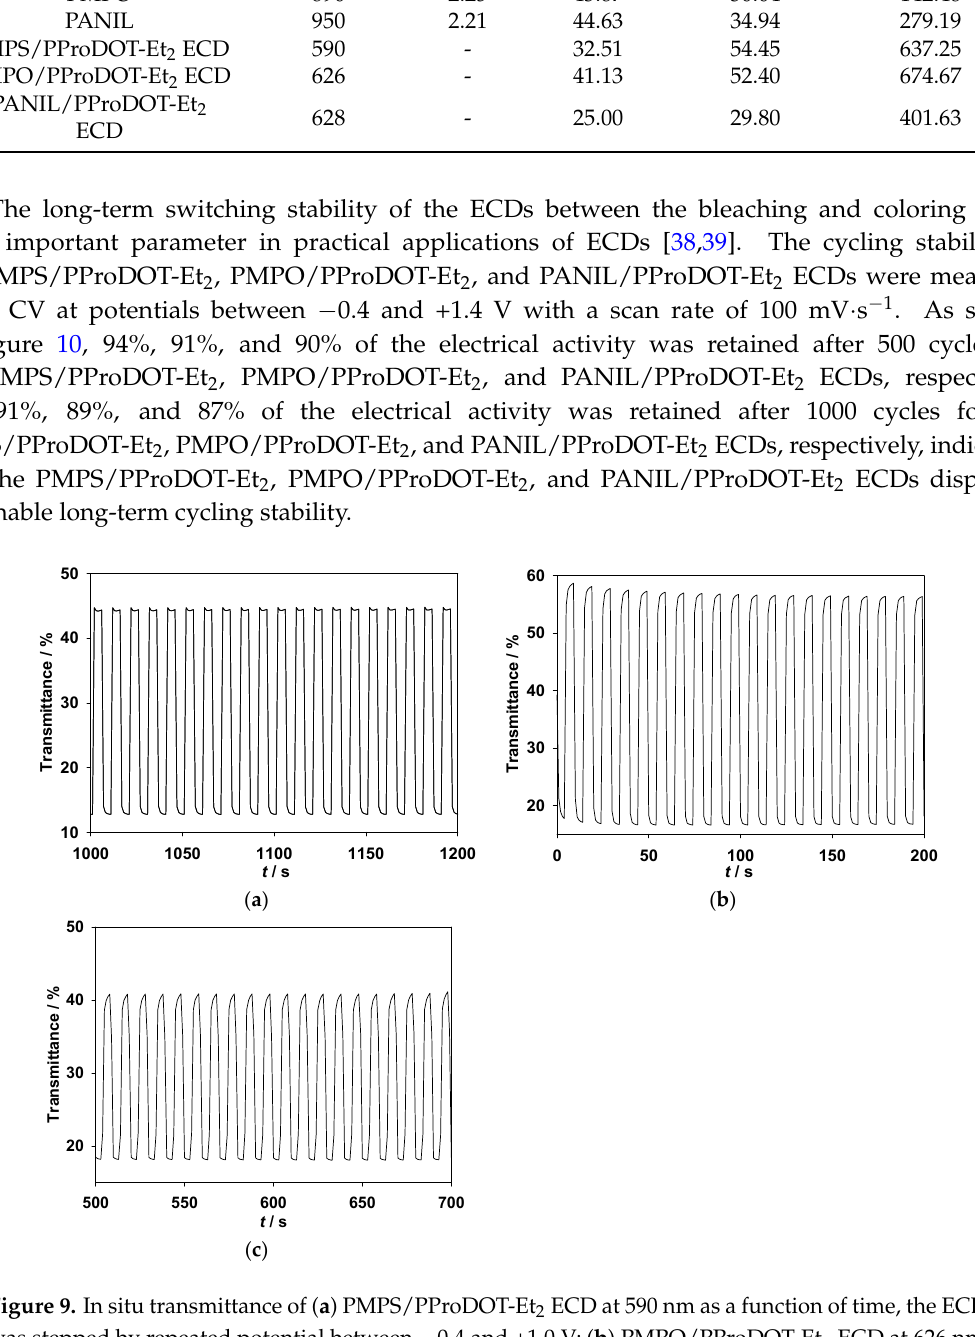
Table 5. Comparisons of the Δ T max and η max for various polymer films and ECDs.